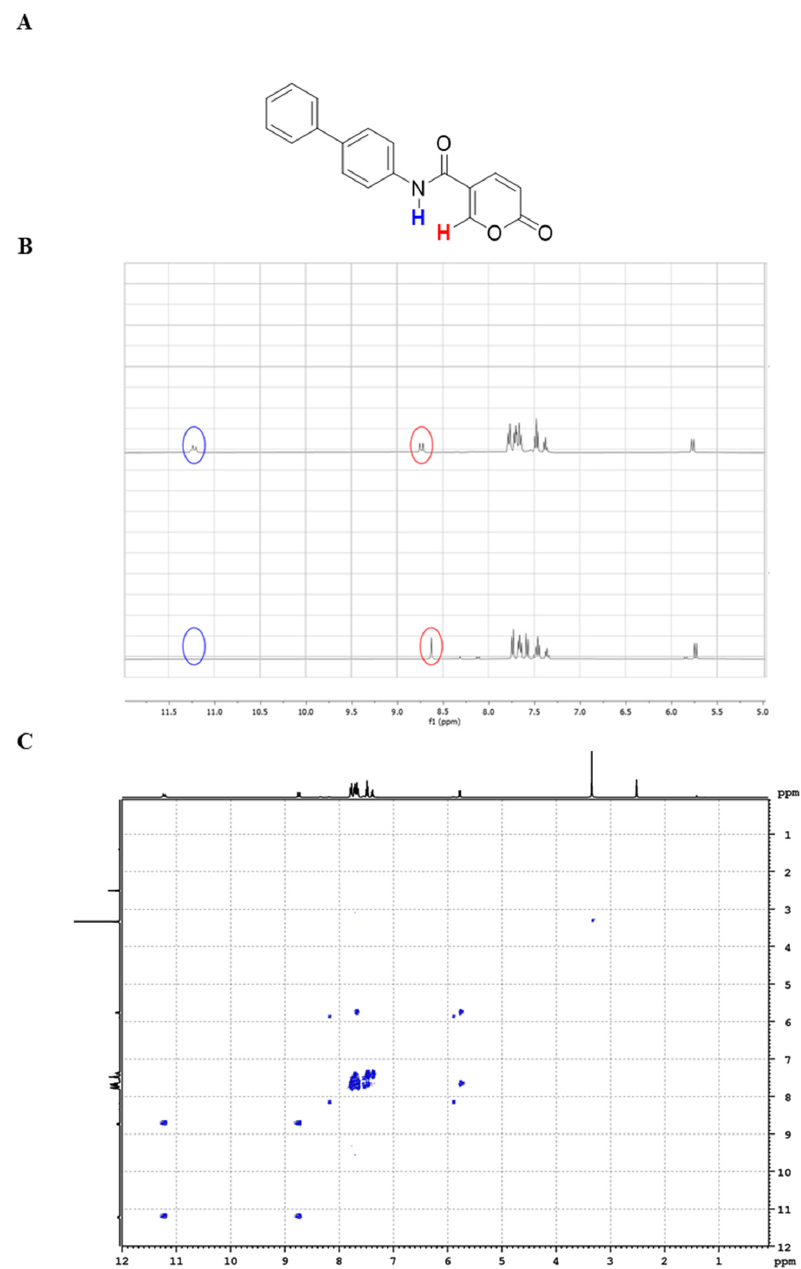
Figure 3. ( A ) Structure of compound 11 , involved in the NMR studies. ( B ) 1 H-NMR spectrum of compound without (high) and after (downward) D 2 O addition. ( C ) 1 H- 1 H NMR-COSY spectrum of compound 11 (the peaks at 2.50 and at 3.33 ppm are related to solvents).